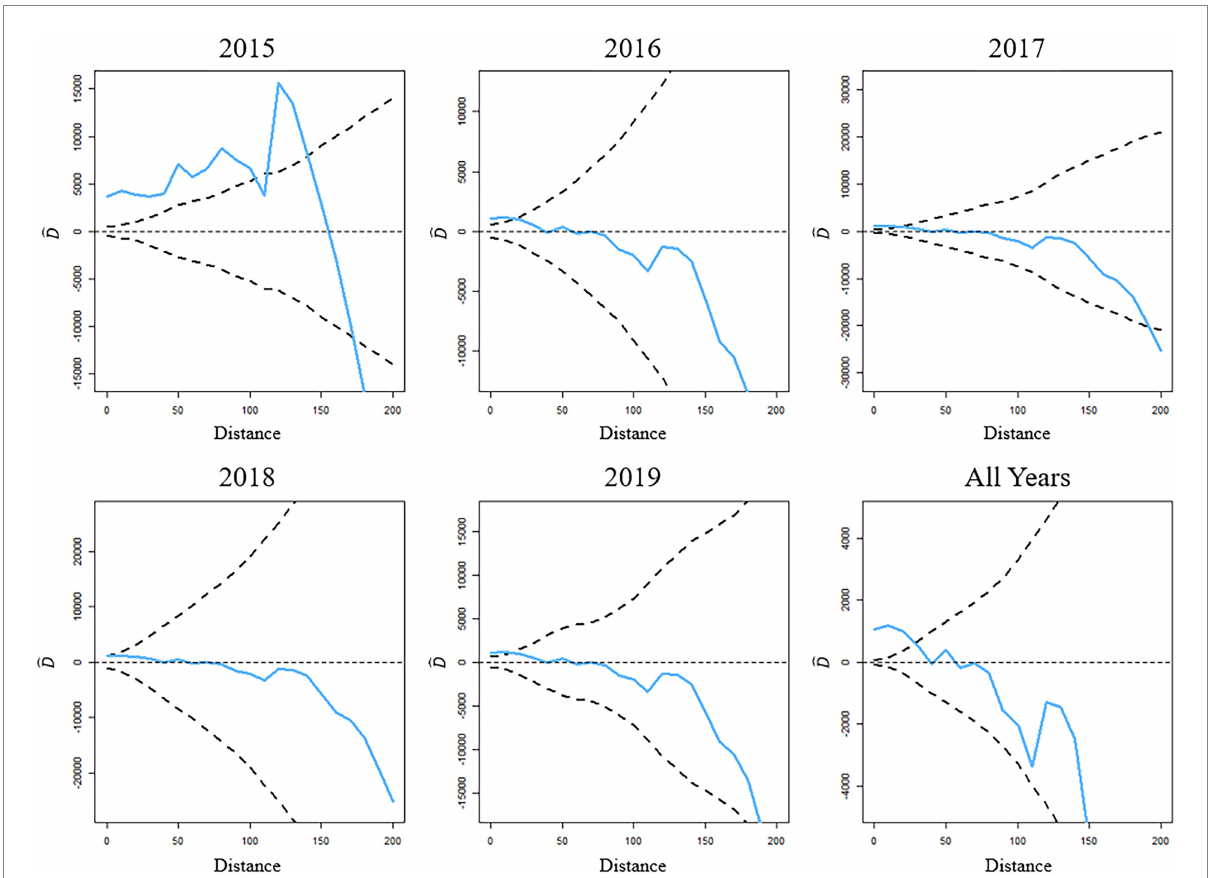
FIGURE 2 D-Functions for inspected colony locations in Southern Ontario with V. destructor counts equaling or exceeding 3 mites per 100 bees for each of the study years and the 5-year study period combined. Upper and lower 95% confidence limits derived from MCMC are indicated by the dotted lines.